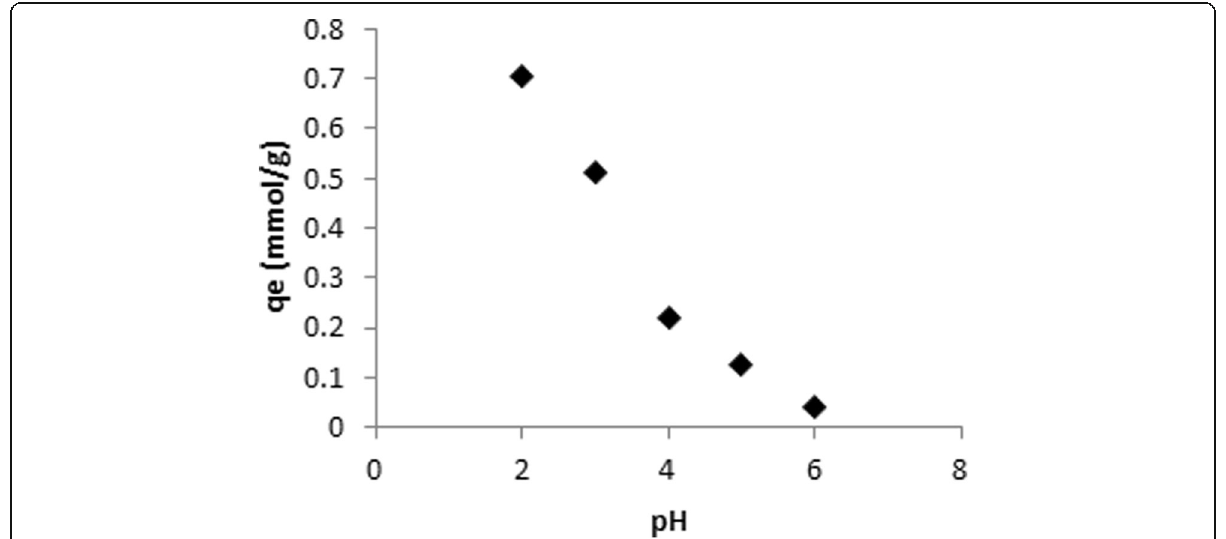
Fig. 11 pH effect on Cr (VI) adsorbed by N6,6/GO (equilibrium time: 6 h, dosage: 2 g/L, temperature: 25 °C)